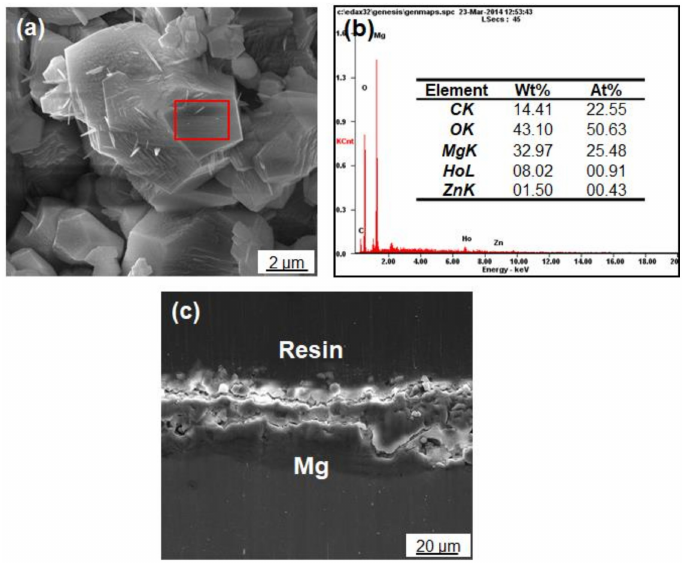
Figure 3. ( a ) SEM micrograph; ( b ) elemental composition; and ( c ) cross–section micrograph of the HT2